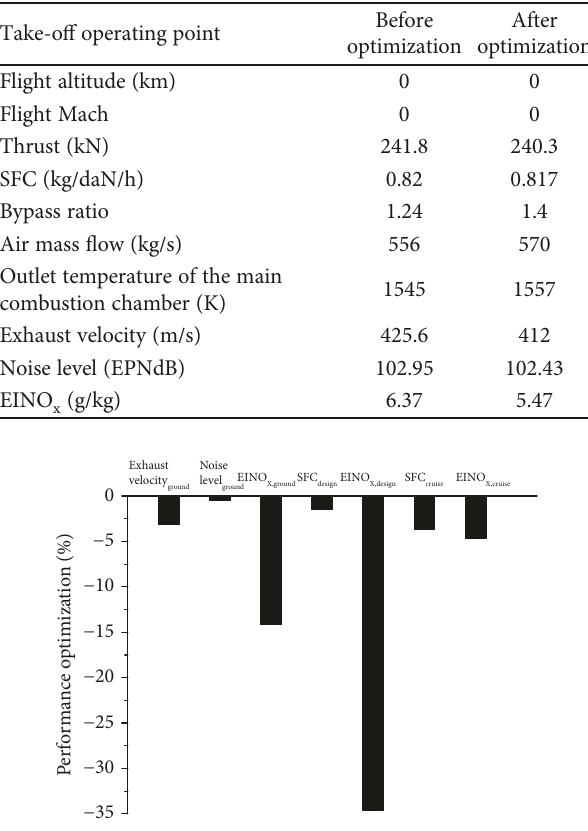
Figure 23: Optimization results of TBCC engine